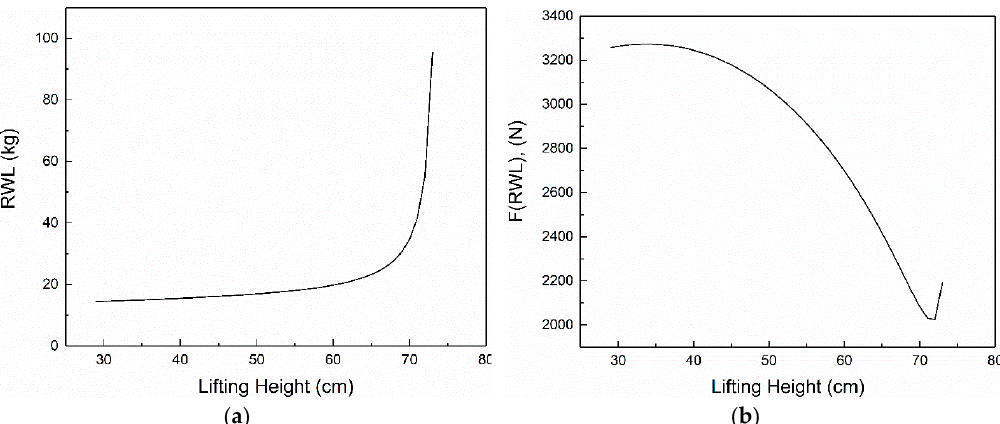
Figure 2. The relationship between RWL , F ( RWL ) and h . ( a ) The relationship between RWL and h ; ( b ) The relationship between F ( RWL ) and h.